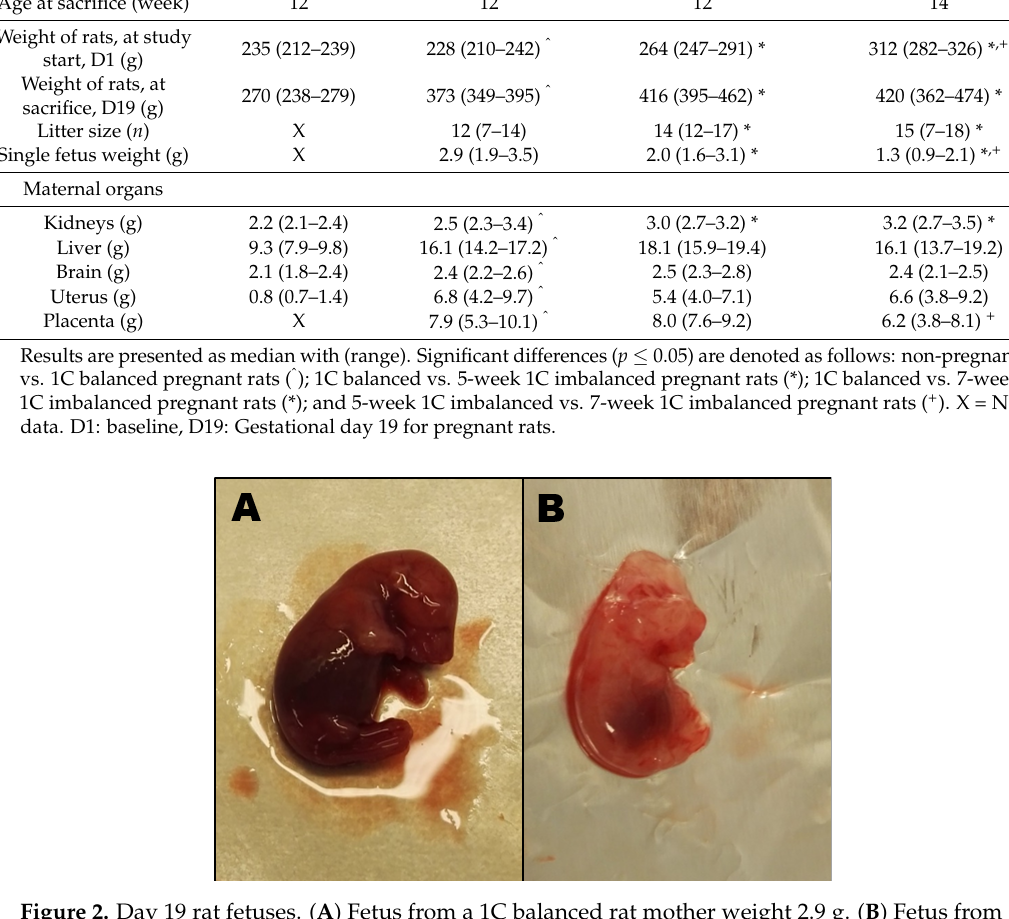
Figure 2. Day 19 rat fetuses. ( A ) Fetus from a 1C balanced rat mother weight 2.9 g. ( B ) Fetus from a 7-week 1C imbalanced rat mother showing cranial malformation and general visual underdevelopment, weight 1.3